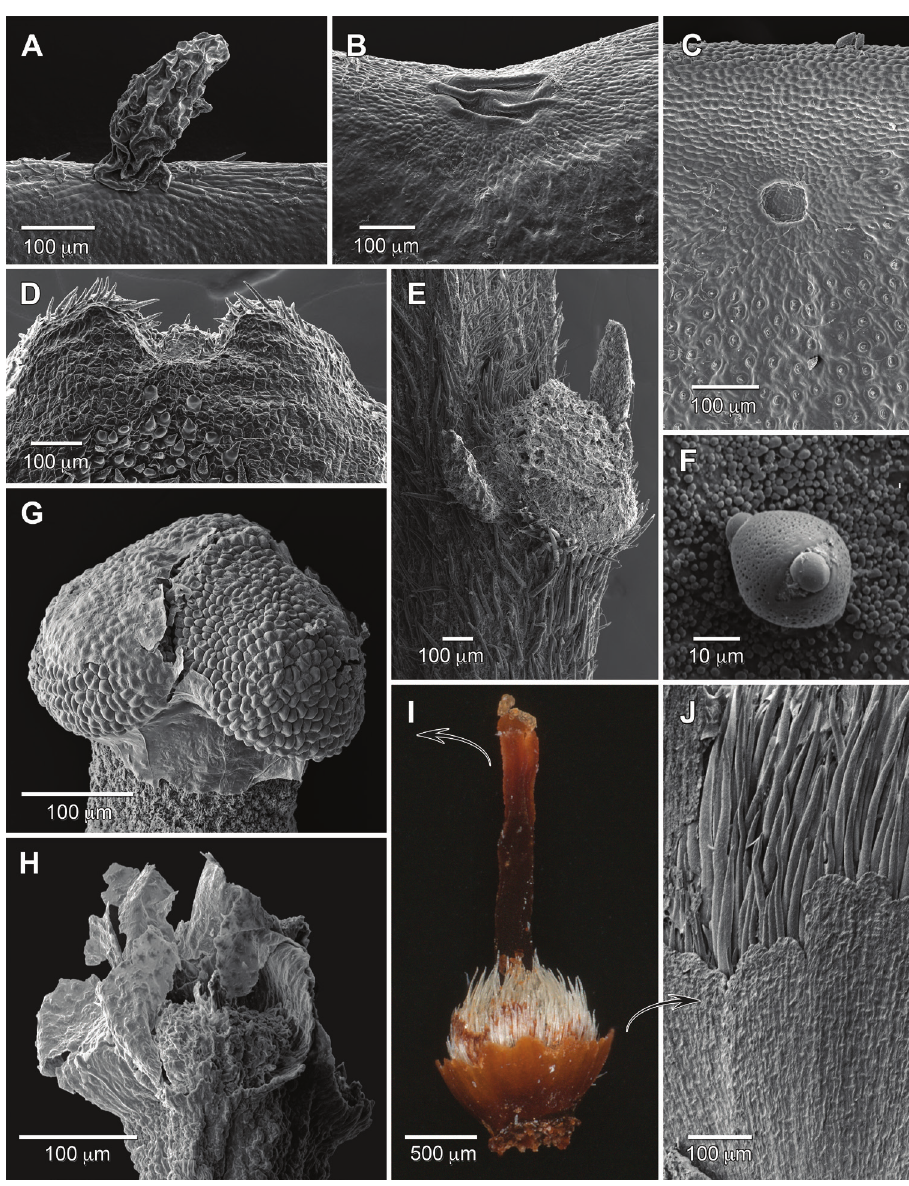
Figure 5 . Micromorphology of Sacoglottis perryi . A Marginal glandular seta B basilaminar gland, adaxial C laminar gland near margin, abaxial D sepal tip, inner side with terminal gland E paired glandular stip- ules and petiole scar F pollen inside sporangium G stigma with ephemeral lobes intact and showing secre- tion H stigma lobes shredded showing thin walls I gynoecium with diagnostic hirsute ovary J glandular disc with erose margin. Sources: A–C Gillespie 2810 D–J Tripp 2984 (all